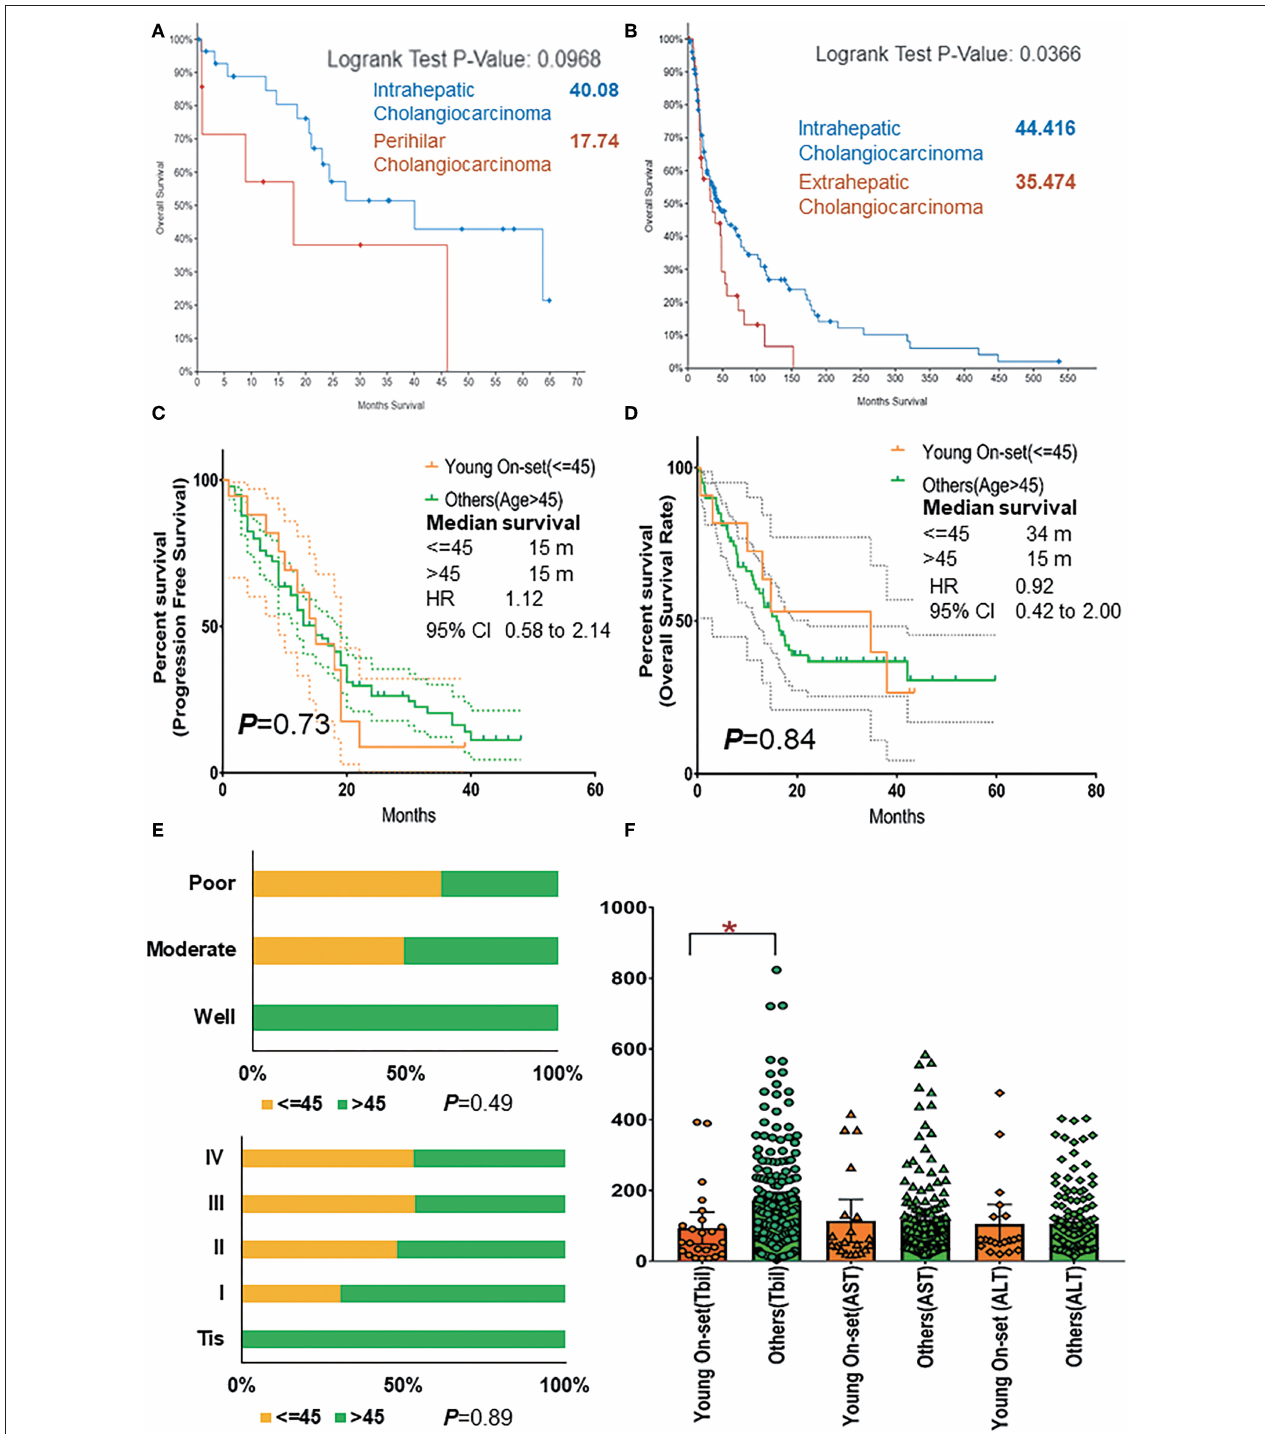
FIGURE 4 | (A) Comparison of overall survival rate of patients with intrahepatic and perihilar CCA basing on cohorts 2 and 3. (B) Comparison of overall survival rate of patients with intrahepatic and extrahepatic CCA basing on cohorts 2 and 3. (C) The progression-free survival rate of AYAs and others (age > 45) with pCCA basing on cohort 1. (D) The overall survival rate of AYAs and others (age > 45) with pCCA basing on cohort 1. (E) The proportion and ratio of different grades of differentiation and different pathological stages in AYA and others (age > 45) group. (F) The comparison of TBil, AST, and ALT expression in AYA ( < = 45, young-onset) group and other ( > 45) group. ALT, alanine transaminase; AST, aspartate transaminase; AYA, adolescents and young adults; CCA, cholangiocarcinoma; pCCA, perihilar CCA; TBil, total bilirubin (blood). * P < 0.05.